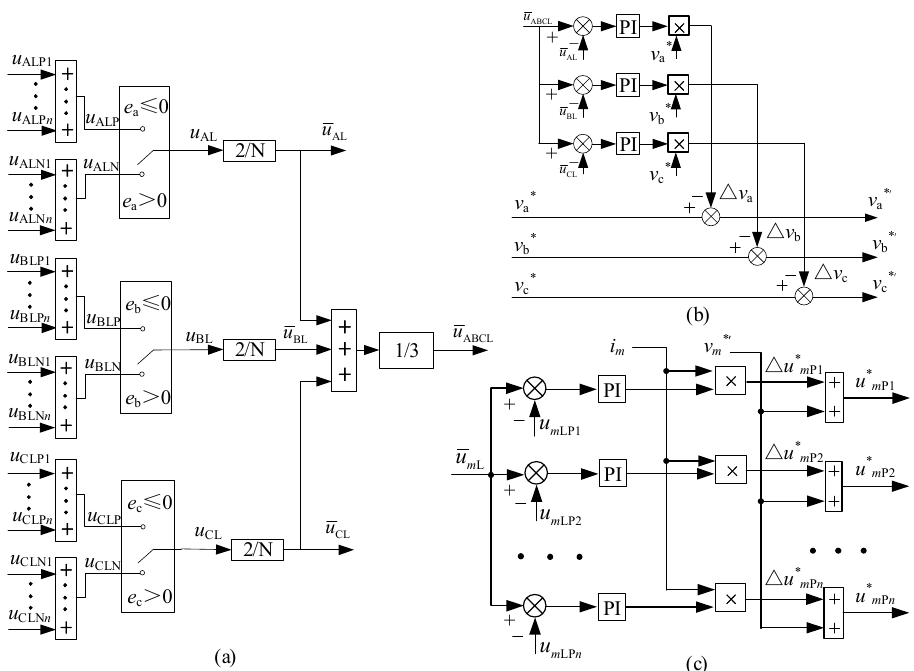
Figure 8. The calculation and control block diagram of the capacitor voltage. ( a ) The calculation block diagram of the average capacitor voltage of the working three-phase upper and lower bridge arms; ( b ) the proposed cluster balancing control method, and ( c ) individual balancing control method of m phase.